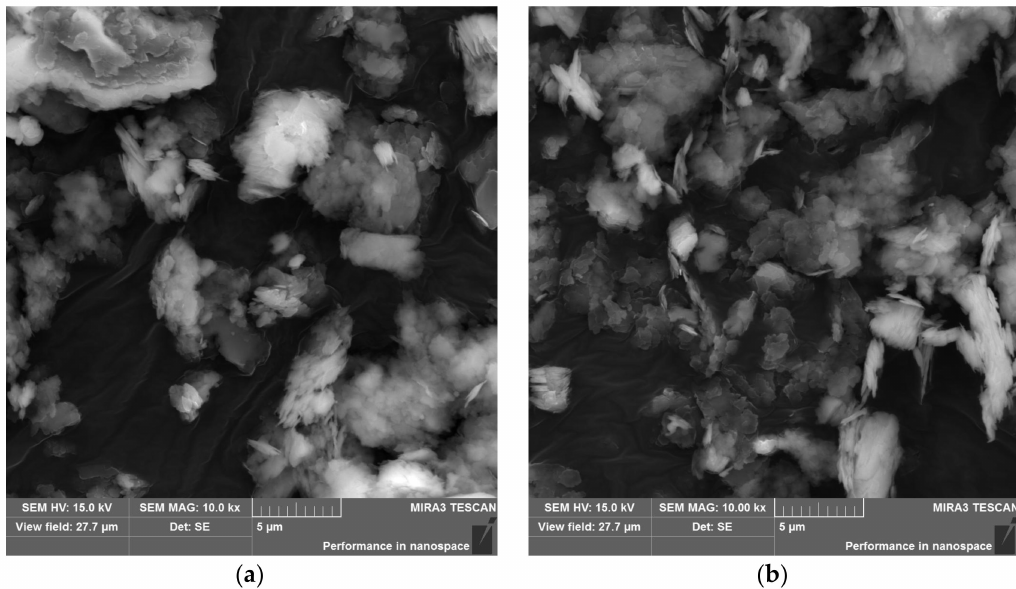
Figure 5. SEM-SE images of ( a ) KC-0 clay and ( b ) KC-1